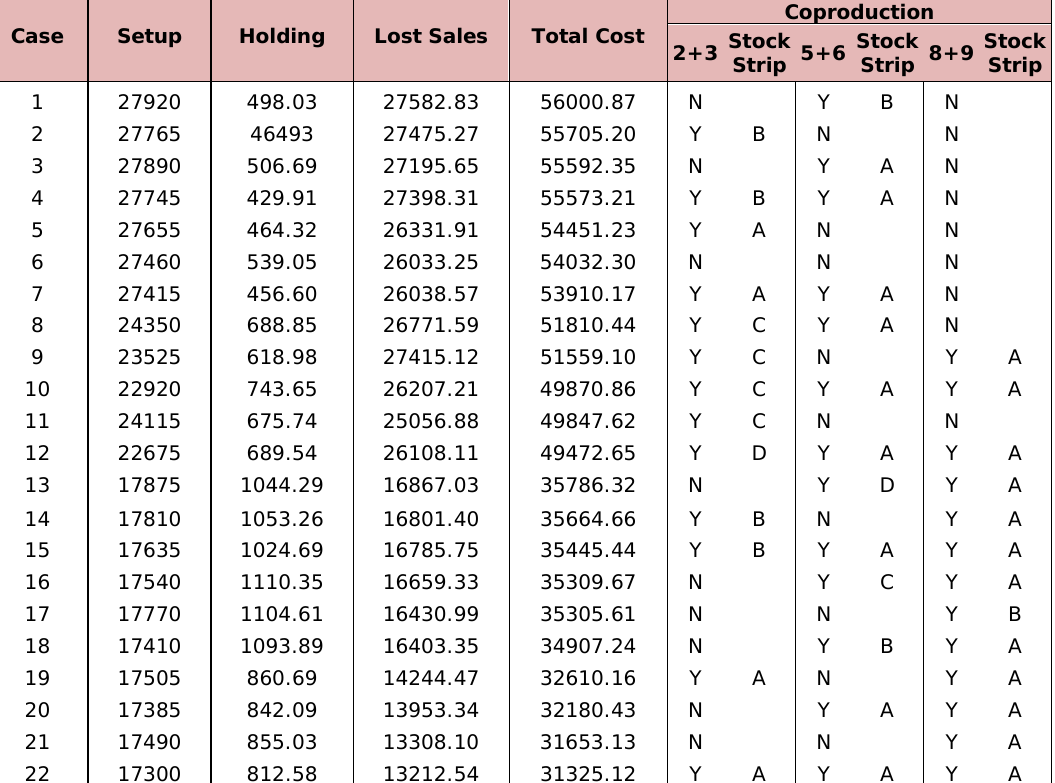
Table 6. “Costs for different coproduction cases by applying the modified Doll and